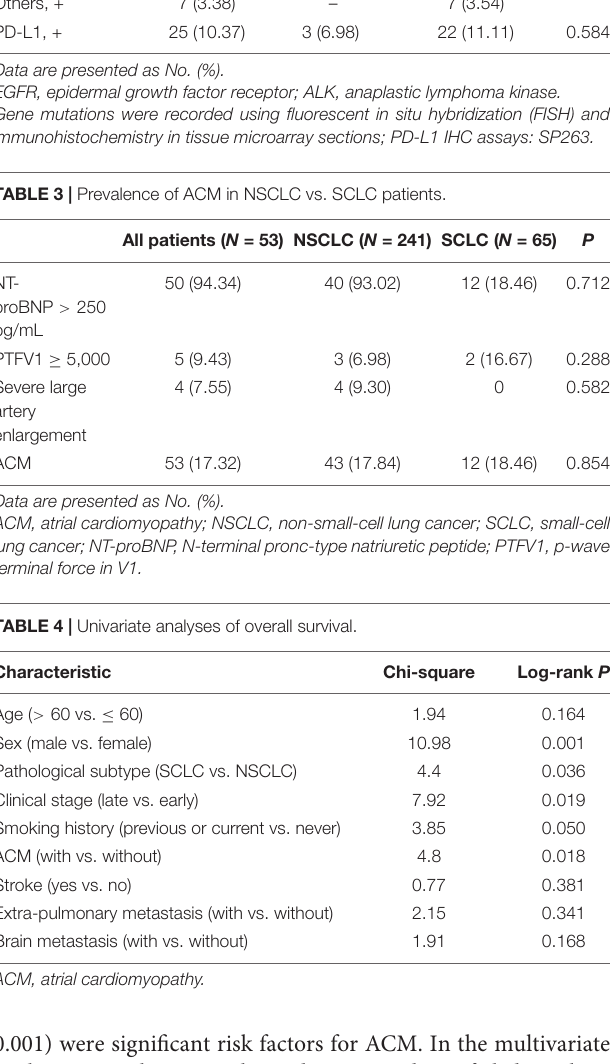
FIGURE 2 | Kaplan–Meier curve of overall survival (OS) based on atrial cardiomyopathy (ACM).